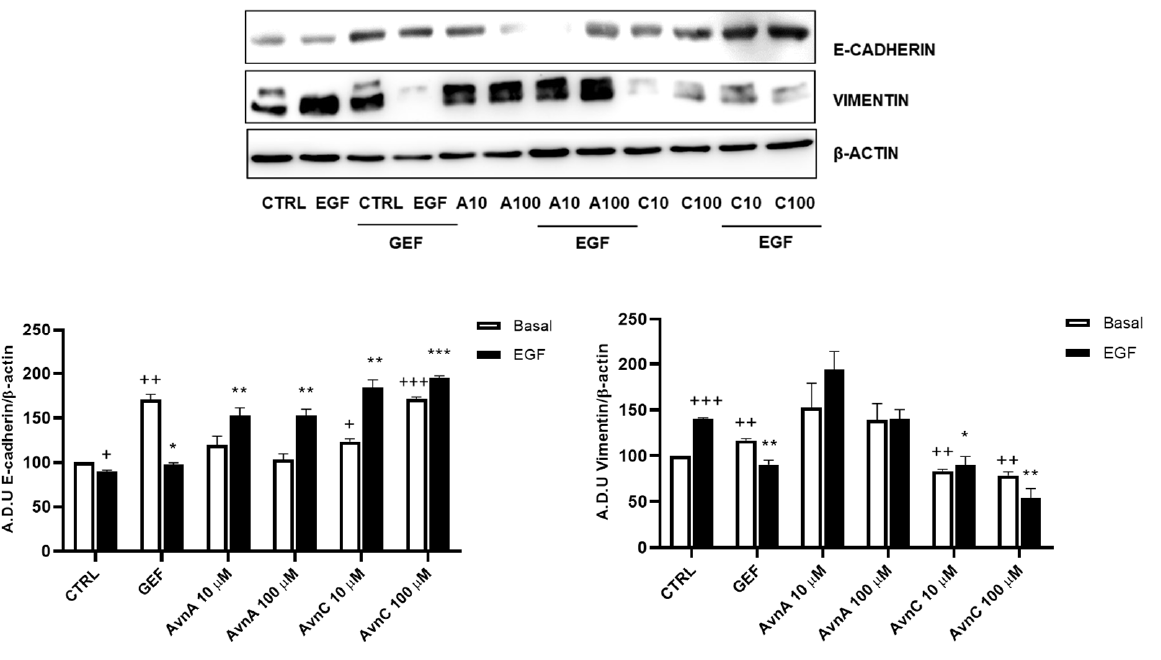
Figure 5. Avns regulate E-cadherin and vimentin expression. Representative images and quantifica- tion of western blot analysis of A549 cells exposed to Avns (10 and 100 µ M, 48 h) (A.D.U: arbi- trary densitometry units). Data are expressed as fold increase compared with control and are rep- resentative of three independent experiments. Statistical analysis: +++ p < 0.001; ++ p < 0.01 and + p < 0.05 vs. CTRL; *** p < 0.001; ** p < 0.01 and * p < 0.05 vs. EGF.